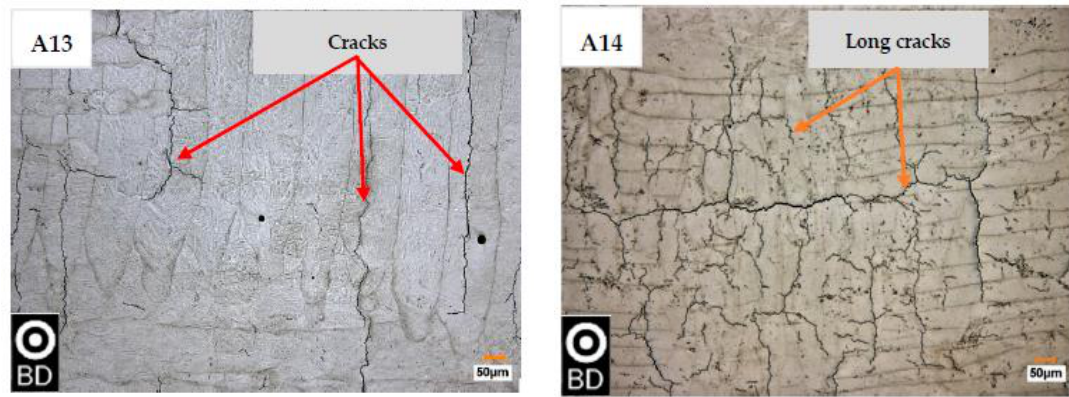
Figure 2. Representative micrographs from perpendicular to build direction of the as-fabricated SLM NiTiHf parts with di ff erent levels of energy density (E v ): ( A3 ) E v = 59.5 J / mm 3 , ( A4 ) E v = 69.4 J / mm 3 , ( A9 ) E v = 104.2 J / mm 3 , ( A11 ) E v = 138.9 J / mm 3 , ( A14 ) E v = 189.4 J / mm 3 , and ( A13 ) E v = 178.5 J / mm 3 . BD shows the building direction.